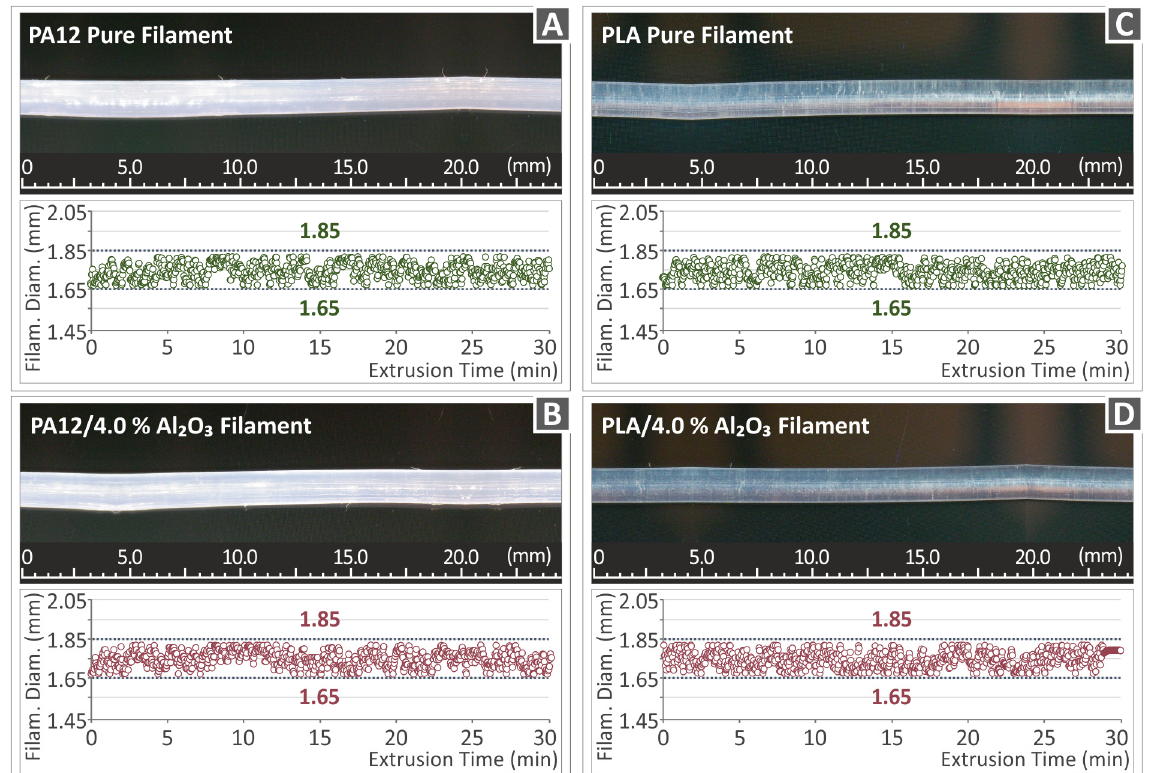
Figure 6. Real-time monitored filament diameter metrology of ( A , C ) neat PA12, ( B , D ) PA12/Al 2 O 3 (4.0 wt.%). ( A , B ) are optical microscope images, ( C , D ) are stereoscope images.